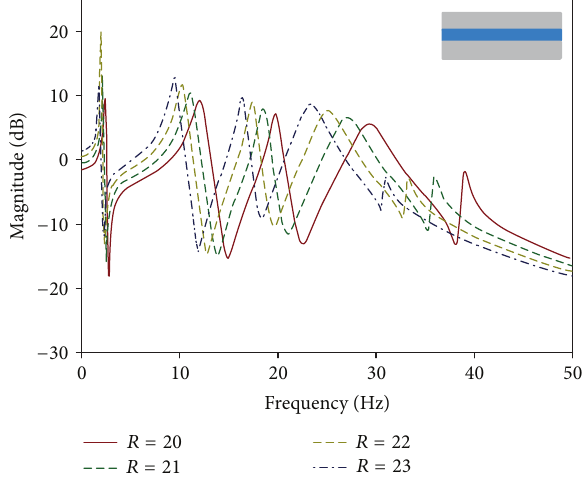
Figure6:Frequencyresponseofcylindricalaluminumpanelincase of SSDL with variety of curvatures 𝑅 ( 𝑎 = 0.2 m, 𝑏 = 0.1 m, 𝑡 1 = = 2 mm, 𝑡 = 5 mm, and 𝜂 = 0.1 5 mm, 𝑡 2 3